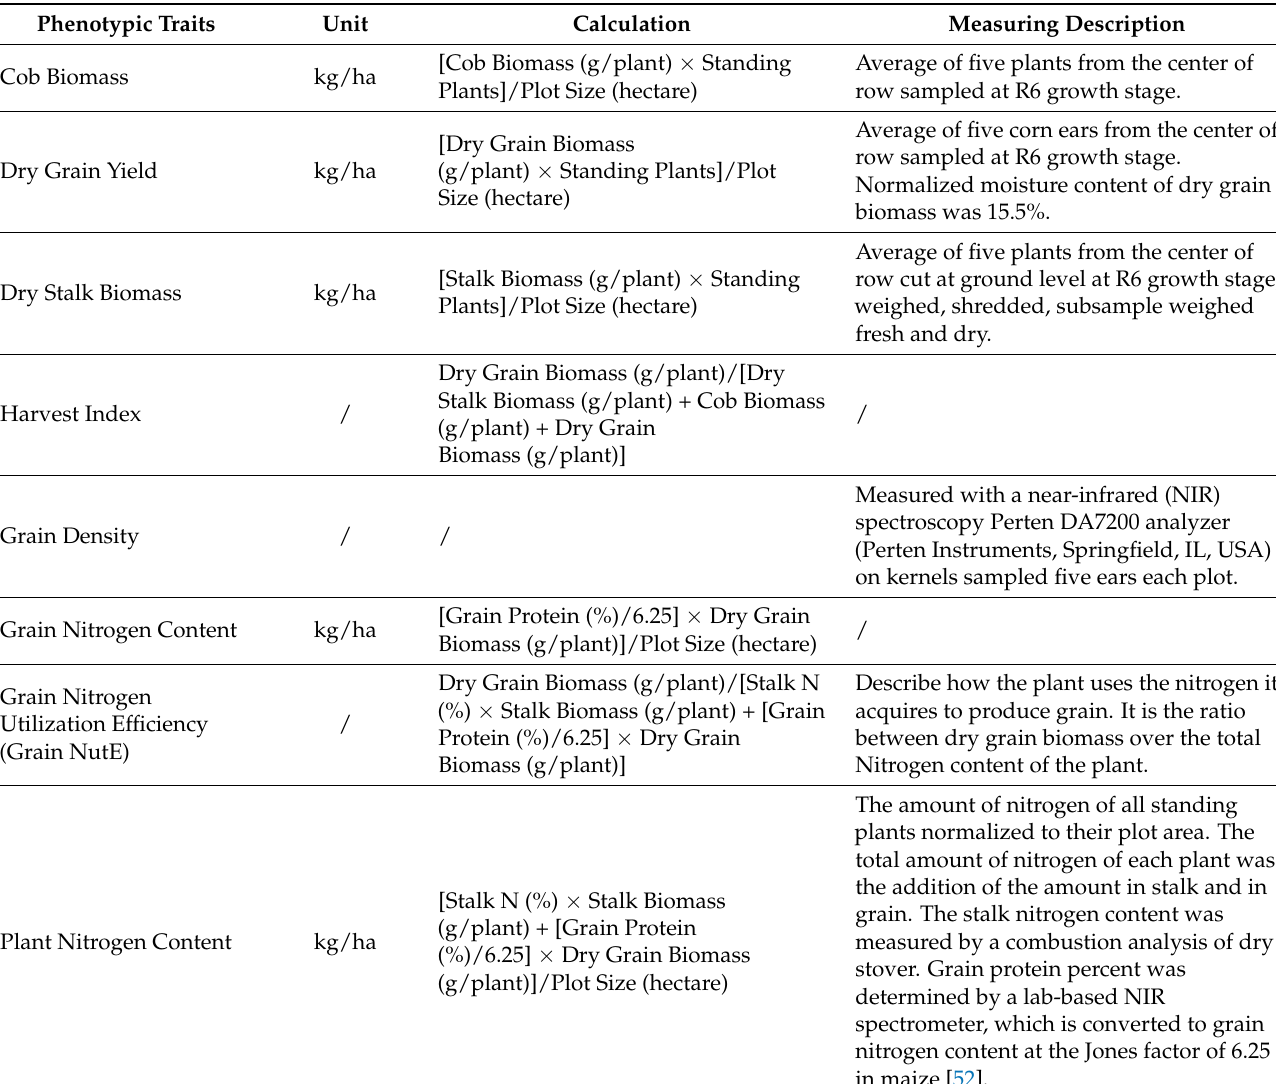
Table 1. Descriptions of maize phenotypic traits and their